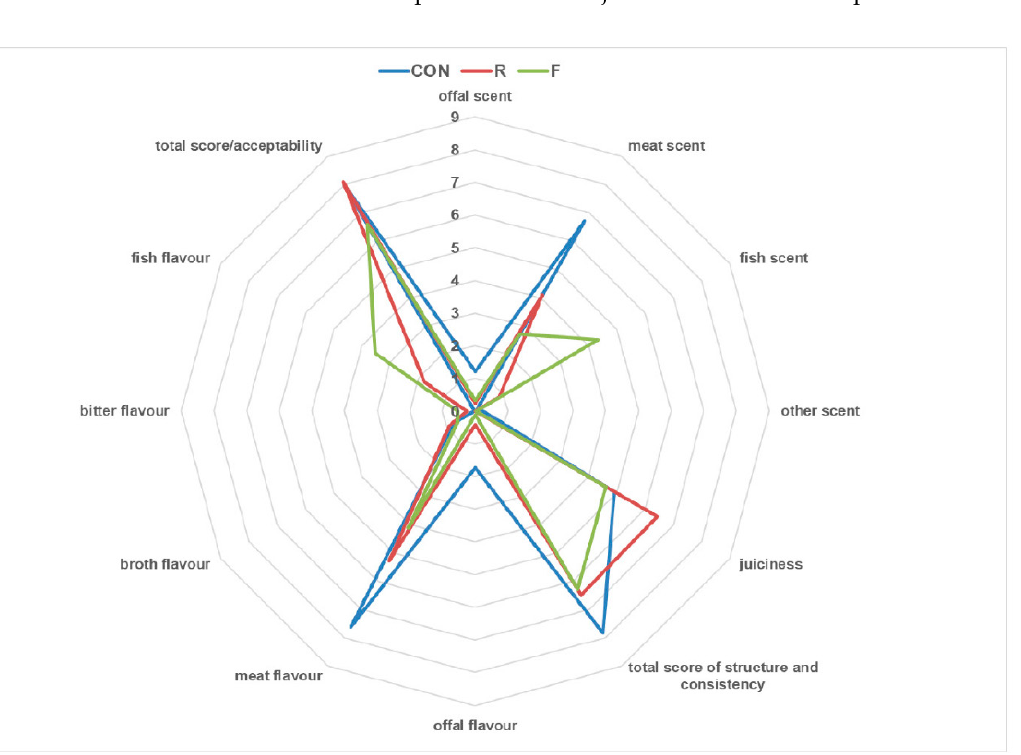
Figure 1. Organoleptic assessment of pork pâtés.